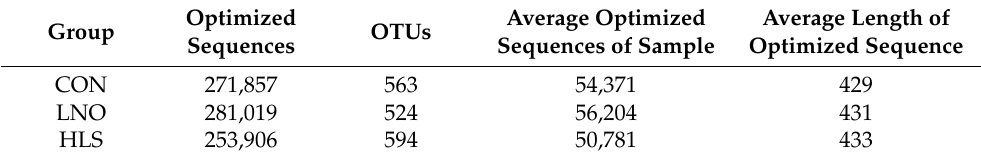
Table 6. Sequence data of bacteria in ileum digesta.